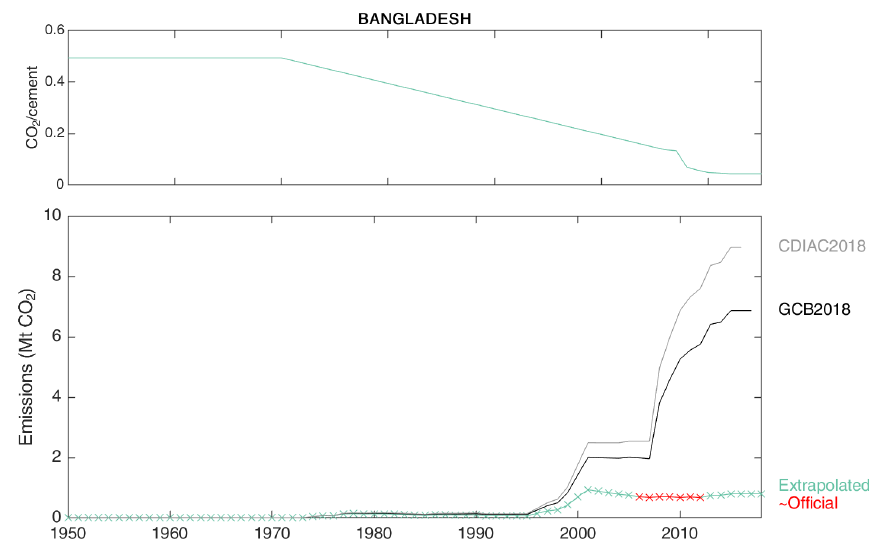
Figure C12. Revised cement emissions in Bangladesh.